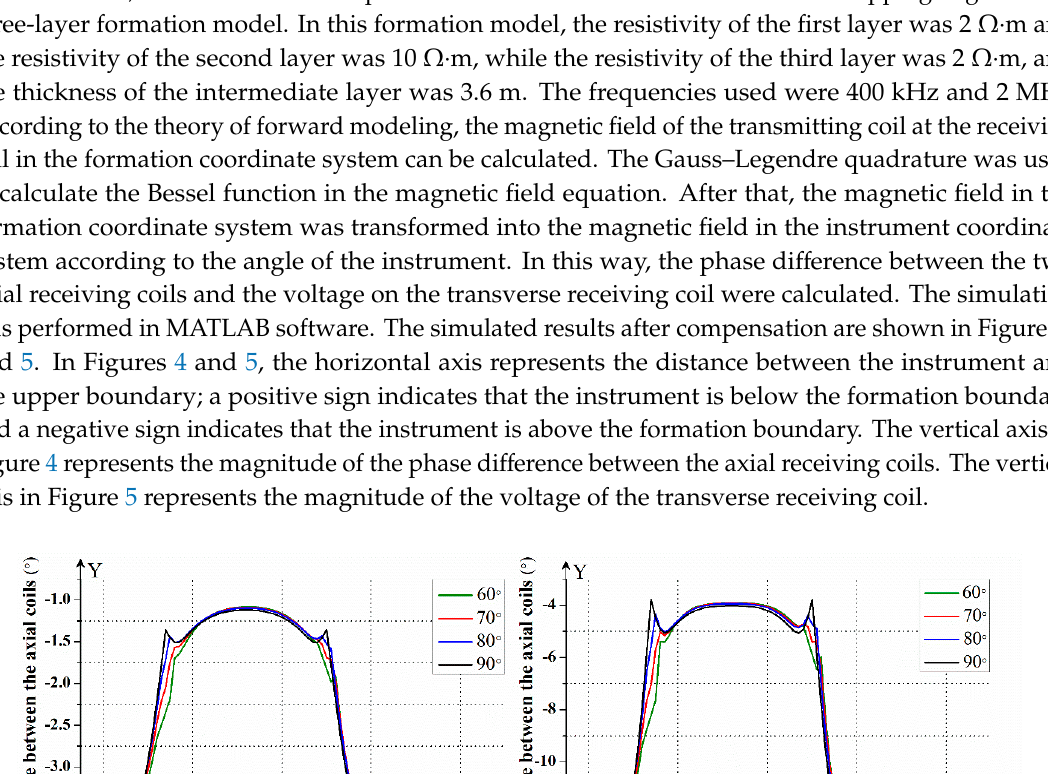
Figure 3. The results of the magnetic field responses on the transverse receiving coil with the number of integral intervals.